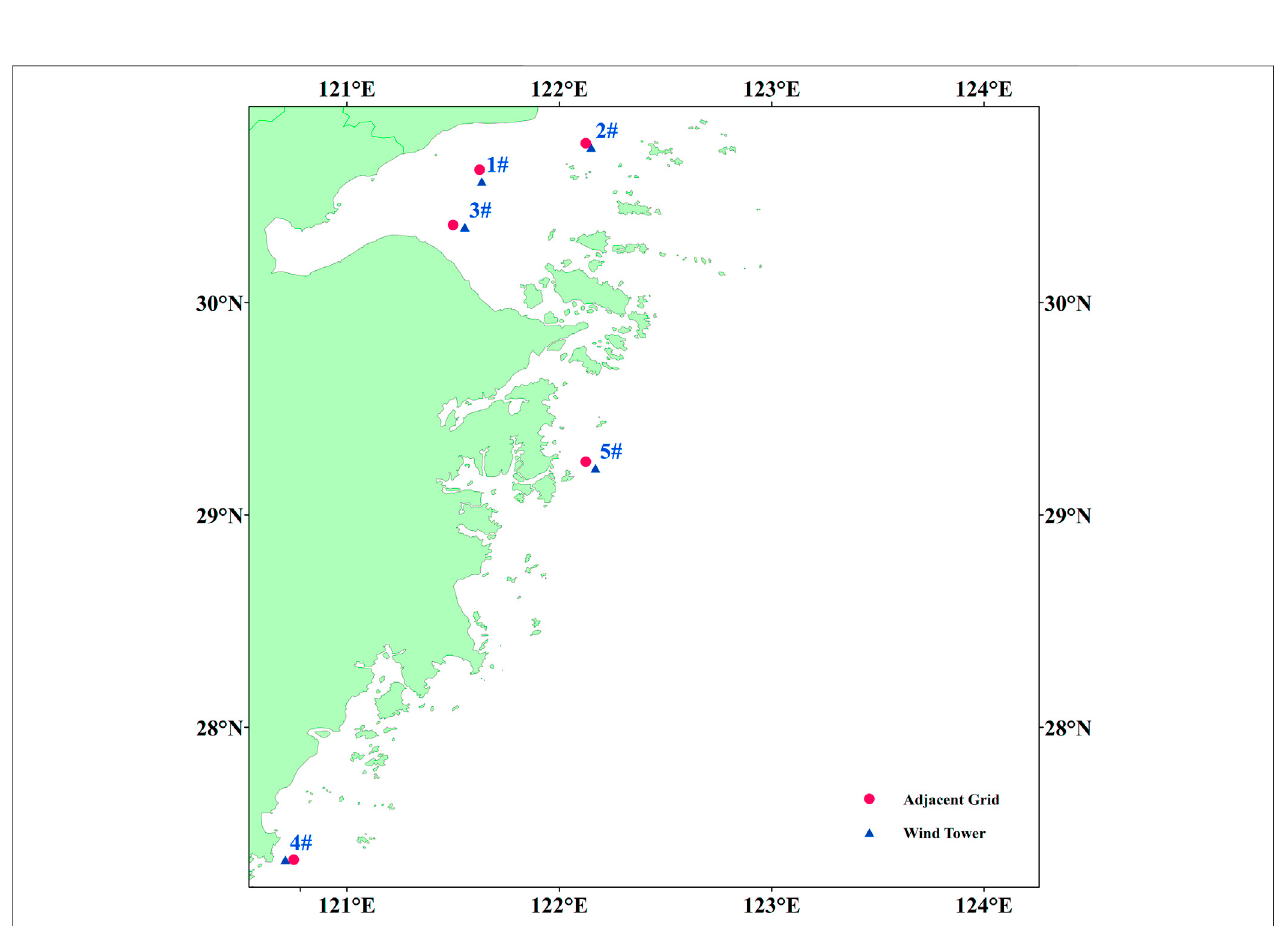
FIGURE 1 | Coastal distribution of wind